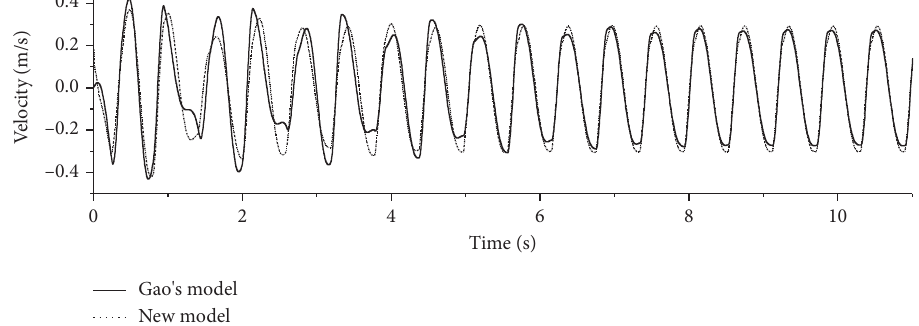
Figure 4: Velocity of the COM in walking (initial vector not optimized).